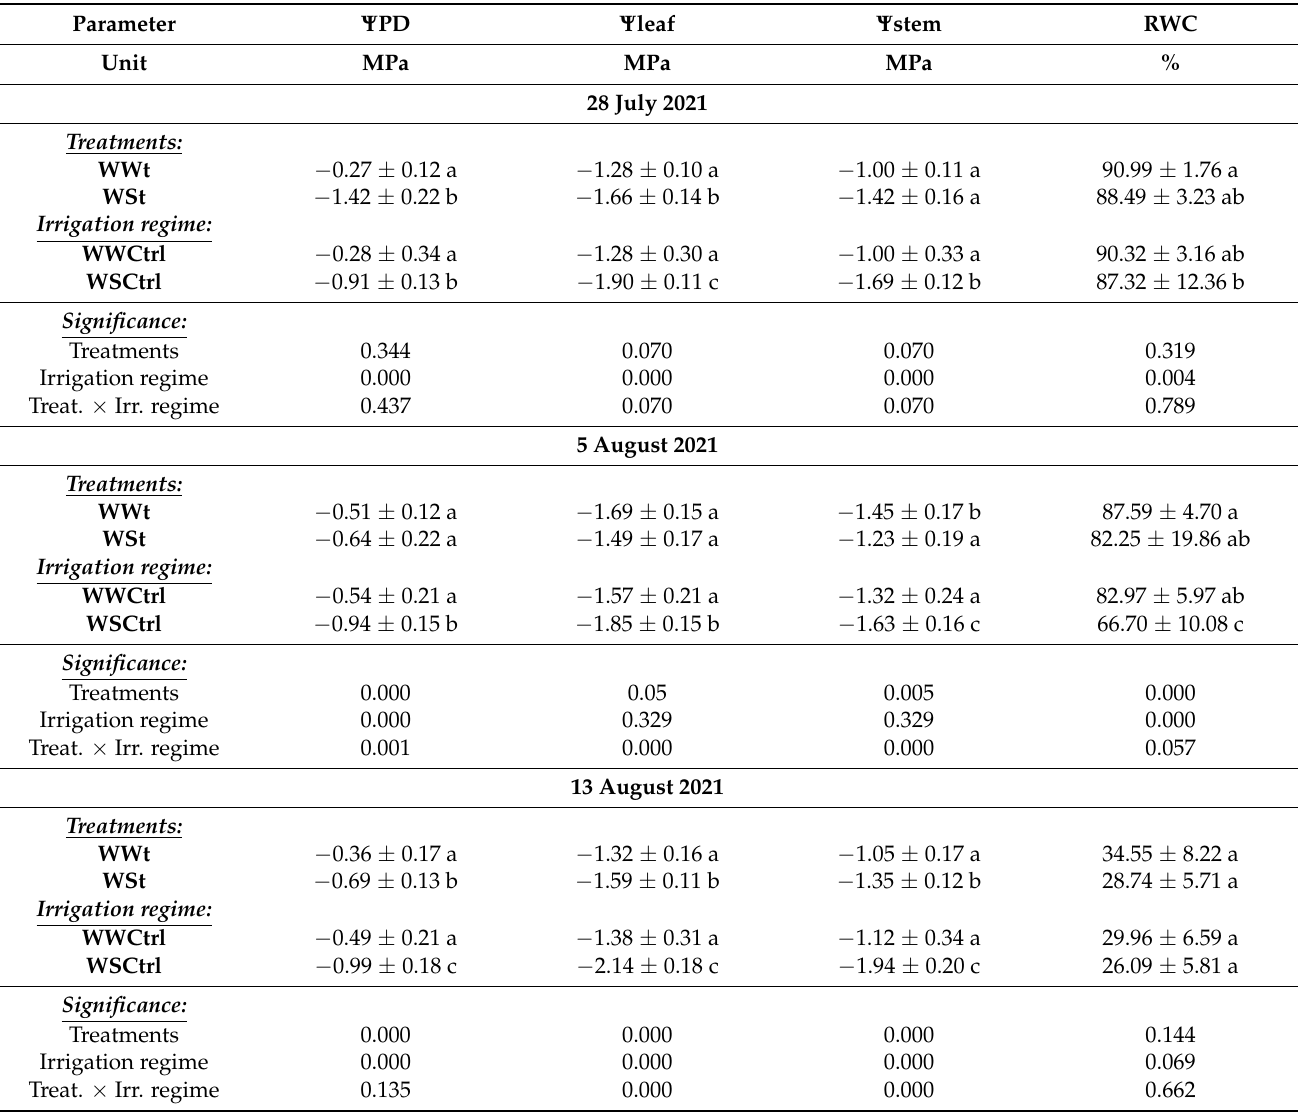
Table 2. Two-way ANOVA ( p < 0.05) for eco-physiology parameters in Vitis vinifera (Pinot Noir cv.) treated with Zeolite (t) and untreated plants (Ctrl), under two irrigation regimes (WW, well-watered; WS, water-stressed). Values are the mean of the data of each parameter, considering treatments (Zeolite and Ctrl) and irrigation regime (Irrig. Regime) as factors. In the last 3 rows is indicated the significance. Other abbreviations: pre-dawn water potential ( Ψ PD), leaf water potential ( Ψ leaf), stem water potential ( Ψ stem), and relative water content (RWC). The same letter pictured on different treatments indicates no significant difference among them (mean ± SE, n =